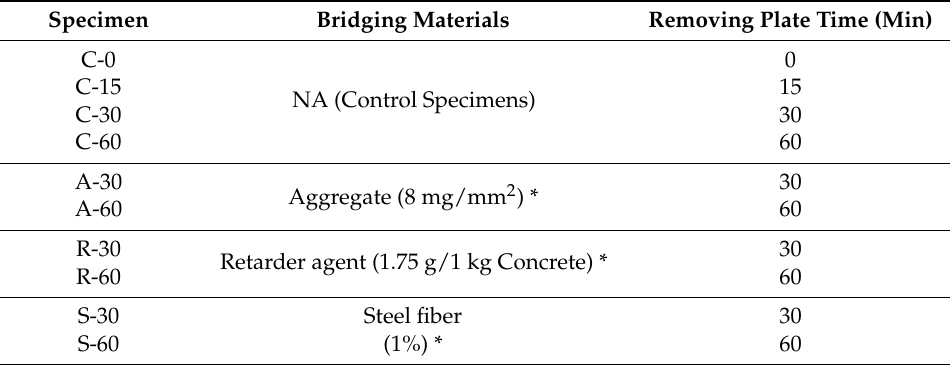
Table 1. Test plan for fracture energy of interfaces.